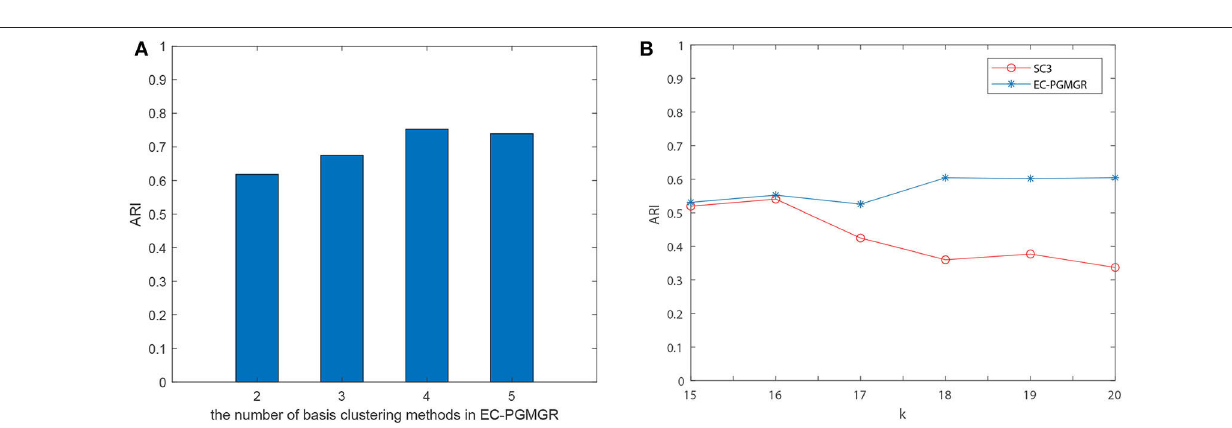
aspects: (1) Consider various number of base cluster methods.